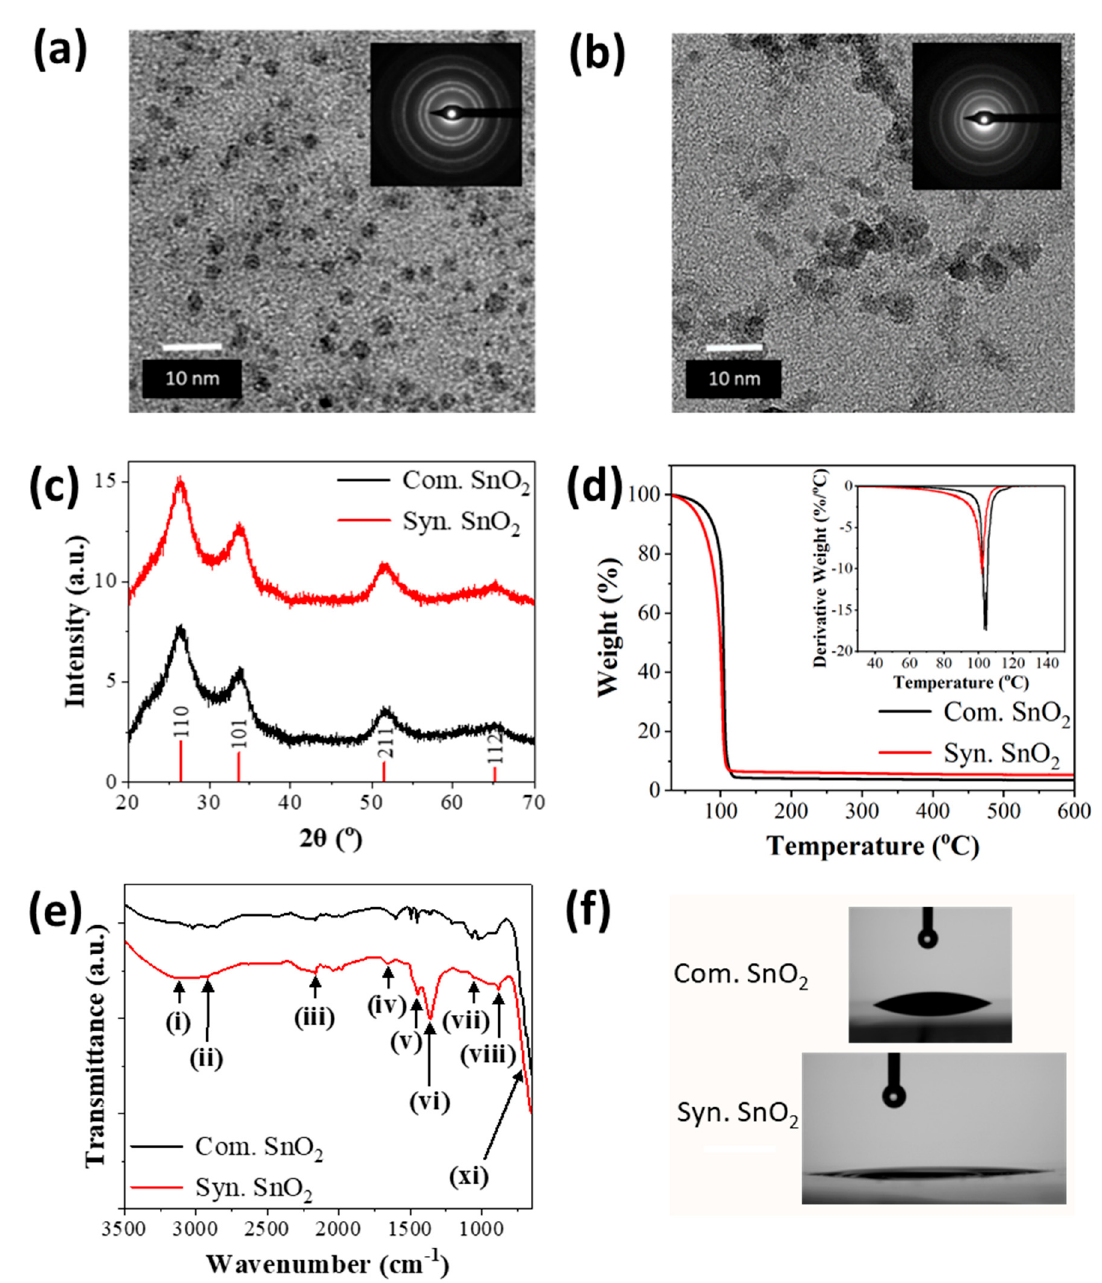
Figure 2. TEM images of ( a ) synthesized and ( b ) commercial SnO 2 nanoparticles, insets are SAED patterns, ( c ) XRD patterns of synthesized and commercial SnO 2 nanoparticles, ( d ) Thermogravimetric plots of synthesized and commercial SnO 2 nanoparticles (inset of 1st derivative plots), ( e ) FTIR spectra of synthesized and commercial SnO 2 nanoparticles; ( i ) OH Str., ( ii ) C-H Str., ( iii ) O = C=O Str., ( iv ) C = O Str., ( v ) C-H Ben., ( vi ) O-H Ben., ( vii ) C-O Str., ( viii ) C-H Ben., ( xi ) Sn-O & O-Sn-O Vib.